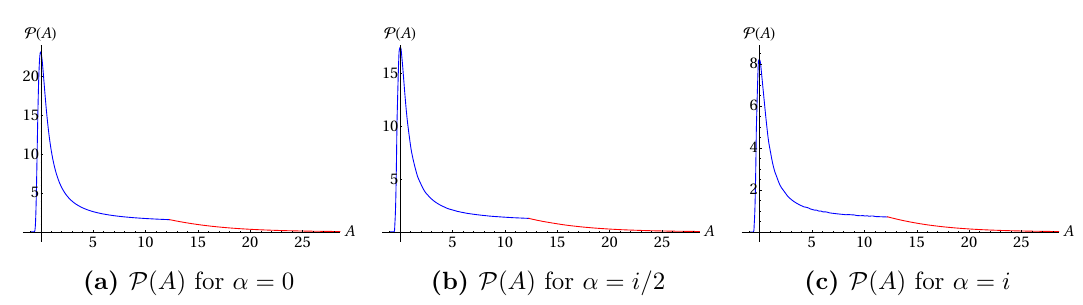
Figure 14. Slices of the probability distributions for B = 0 for three di(cid:11)erent values of (cid:11) . The blue curves show the NUT contributions whereas the dominant Bolt contribution is given in